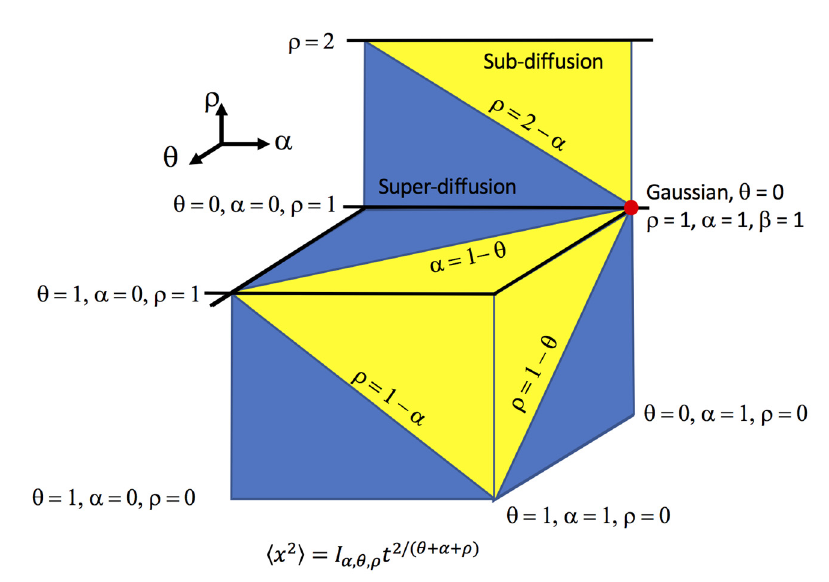
Figure 3. Four faces of the phase cube { α , θ , ρ } are shown in this figure. Each face corresponds to the situation where one of the fractional parameters is fixed: { α , θ = 0, ρ } , { α , θ = 1, ρ } , { α , θ , ρ = 1 } , and { α = 1, θ , ρ } . The faces are divided by diagonal lines along which the mean squared displacement is a linear function of time. Regions of sub- and super-diffusion are displayed in yellow and blue, respectively.